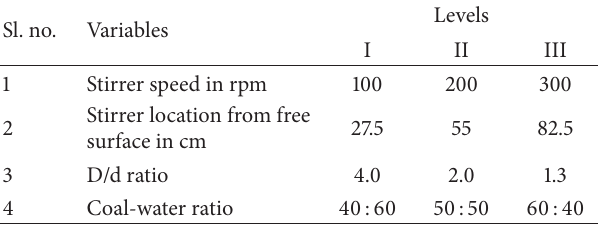
Table 3: Factors and their specified levels.